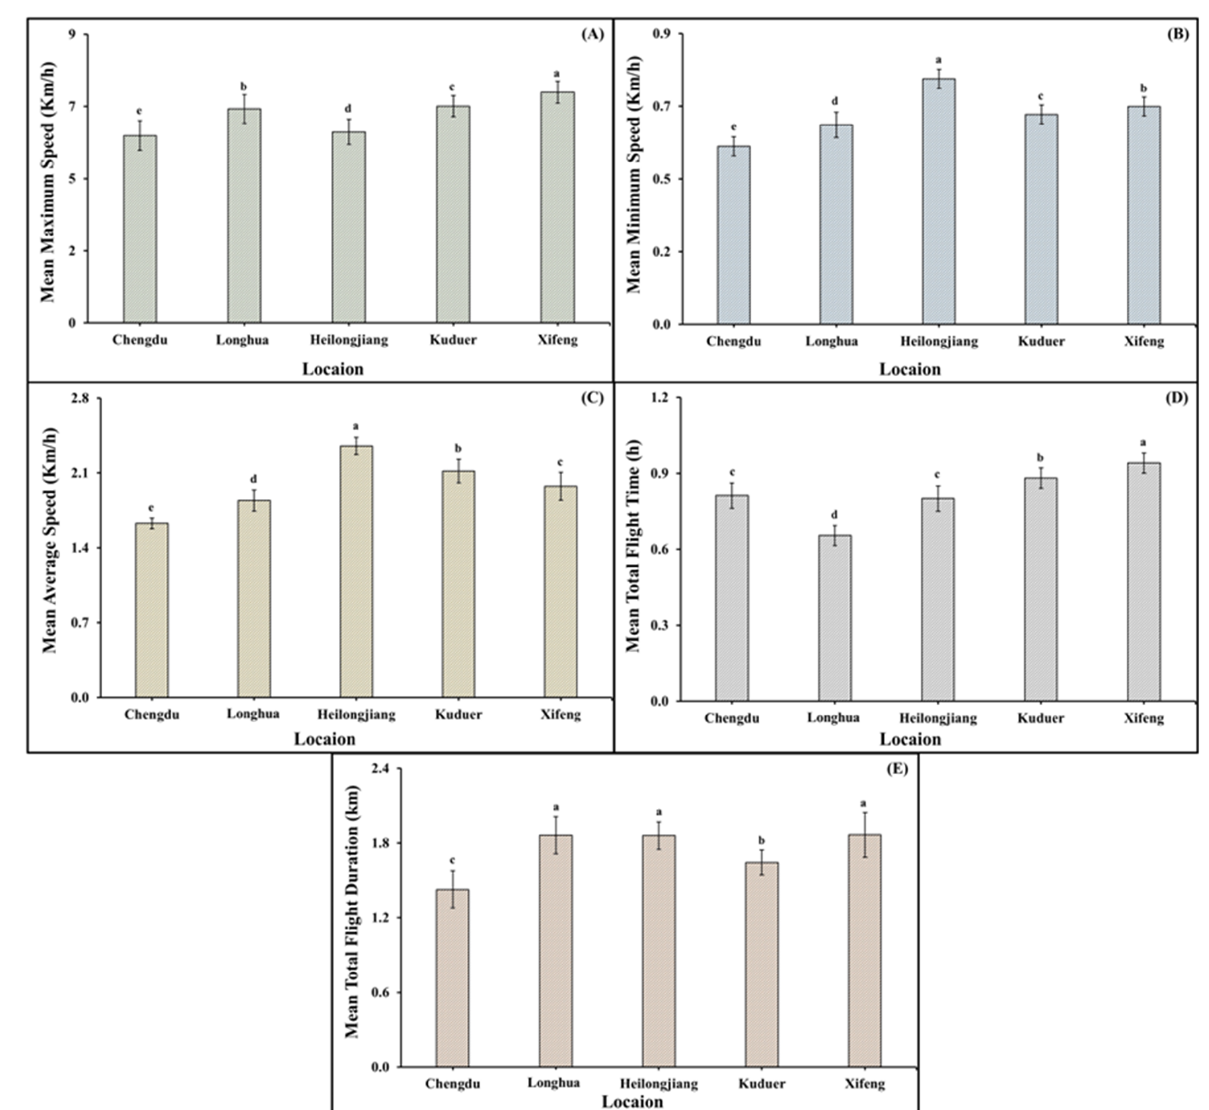
Figure 5. Parameters regarding the flight capability of female Asian spongy moths ( L. dispar asiatica ) from five different locations in China: ( A ) Mean maximum speed of females from five different sites; ( B ) Mean minimum speed of females from five different sites; ( C ) Mean average speed of females from five different sites; ( D ) Mean total flight time of females from five different sites; ( E ) Mean total flight distance of females from five different sites. A level of significance of p < 0.05 was used. Plots are with SE.